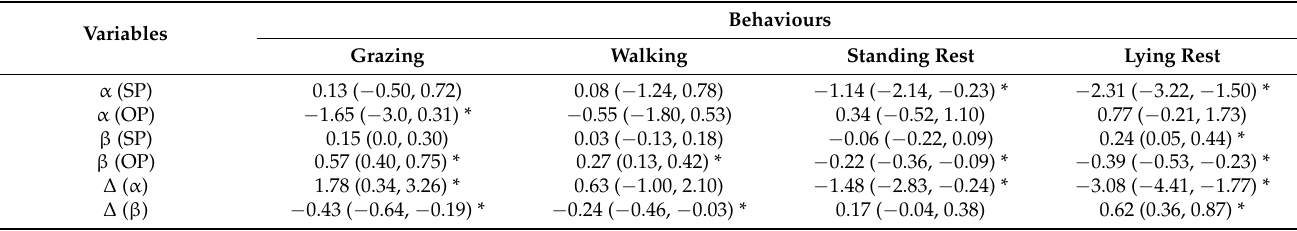
Table 4. Posterior parameter estimates (means and 95% credible intervals in parentheses) of behavioural assessment of lambs in silvopasture (SP) and open pasture (OP) systems. Behaviours Variables Grazing Walking Standing Rest Lying